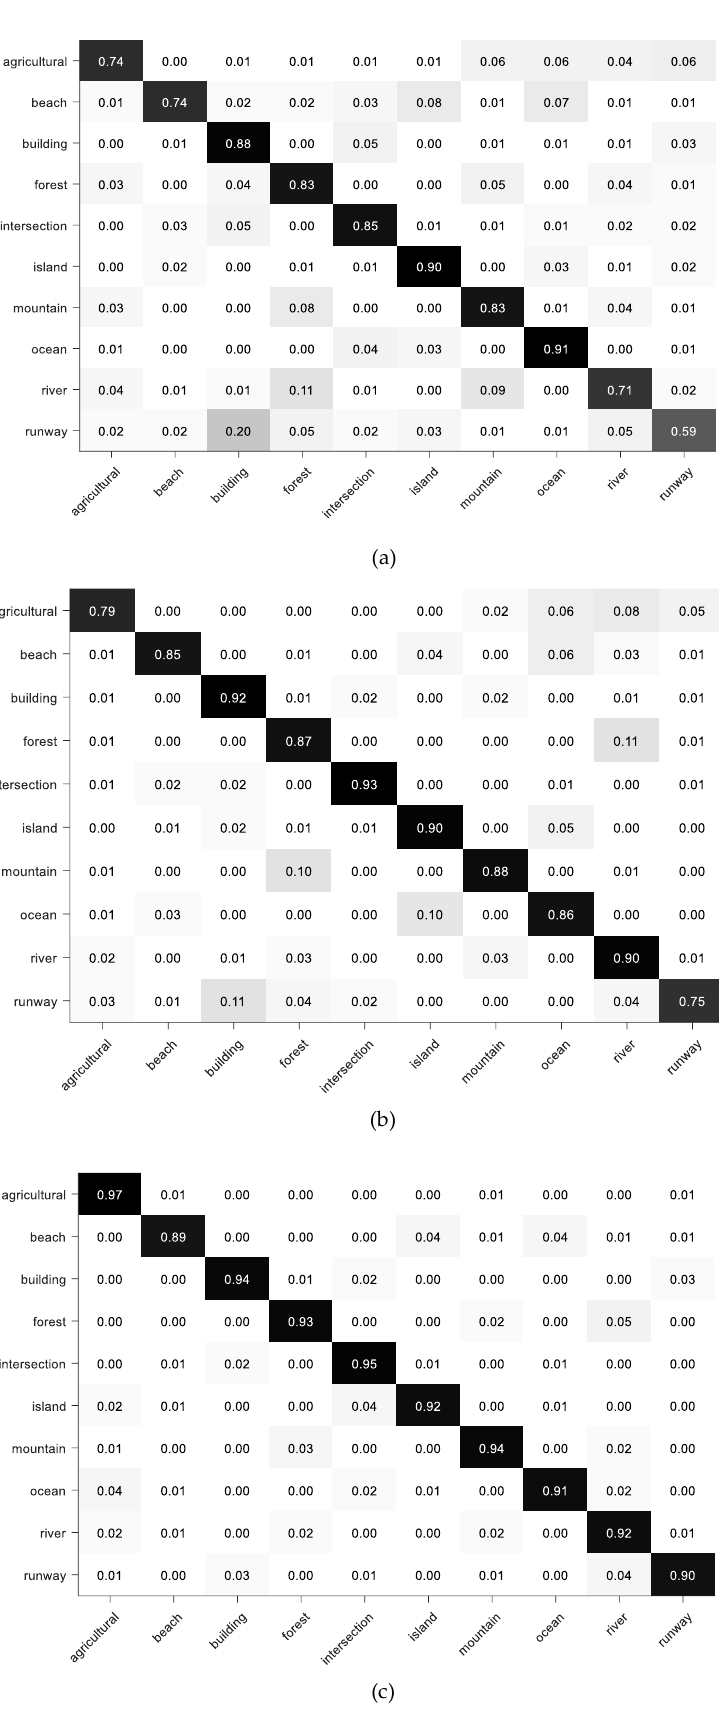
Figure 9. Confusion matrices of the TerraSAR-X dataset under the training ratio of 10% using the following methods: ( a ) LLC + SIFT. ( b ) VLAD + SIFT . ( c ) GCCH (ours). following methods: ( a ) LLC + SIFT. ( b ) VLAD + SIFT. ( c ) GCCH